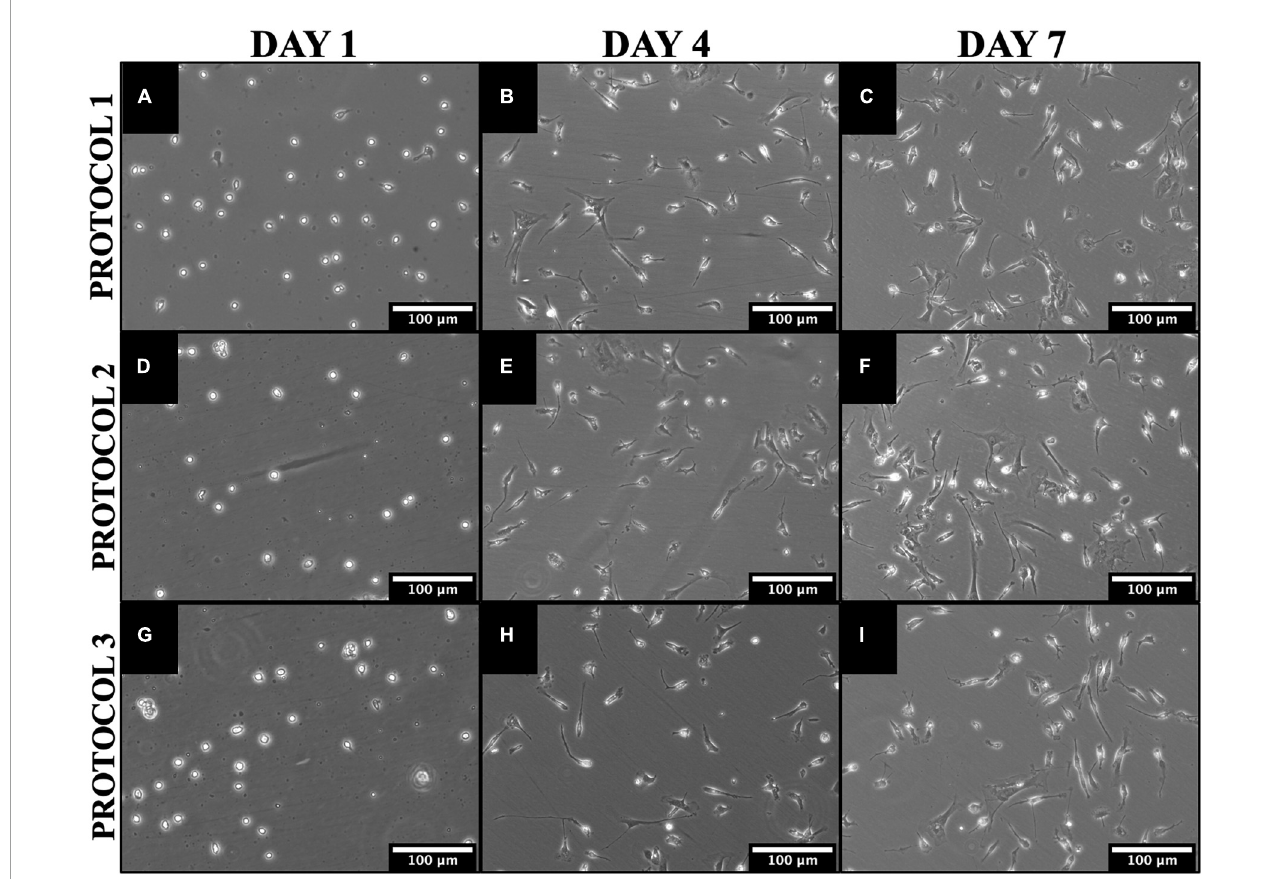
FIGURE3 Morphological and proliferative differences between cells isolated by different methods. Representative phase-contrast images of mouse microglia cultures over 7 days in culture illustrating significant growth time points for PROTOCOL 1 (A–C) , PROTOCOL 2 (D–F) , and PROTOCOL 3 (G–I) . Scale bars: 100 µ m.